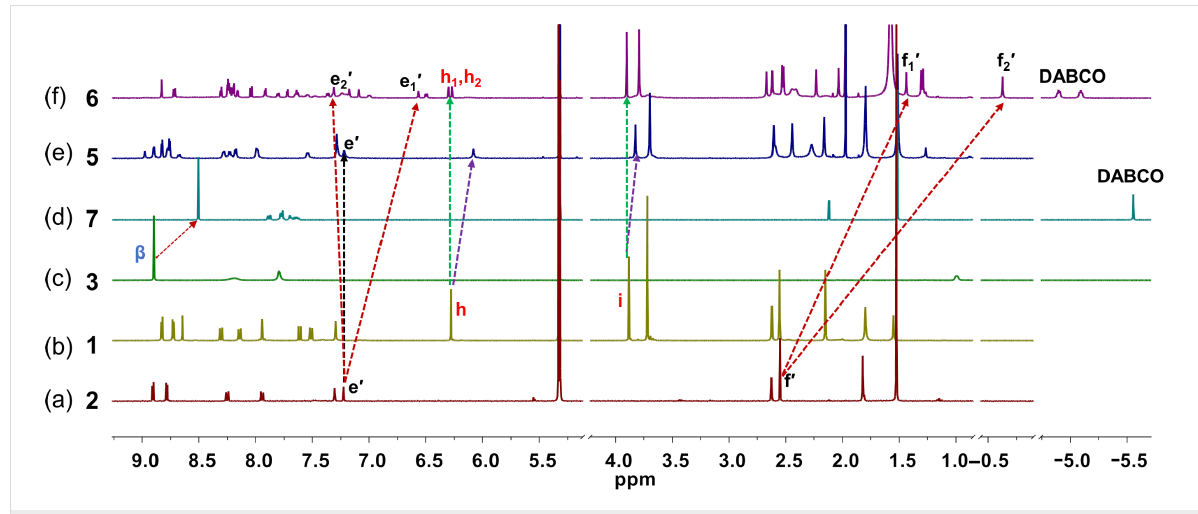
Figure 2: Comparison of partial 1 H NMR spectra (400 MHz, CD 2 Cl 2 , 298 K) of (a) ligand 2 ; (b) ligand 1 ; (c) porphyrin 3 ; (d) complex 7 = [( 3 ) 2 ( 4 )]; (e) rectangle 5 = [Cu 4 ( 1 ) 2 ( 2 ) 2 ] 4+ ]; (f) sandwich complex 6 = [Cu 2 ( 1 )( 2 )( 4 )] 2+